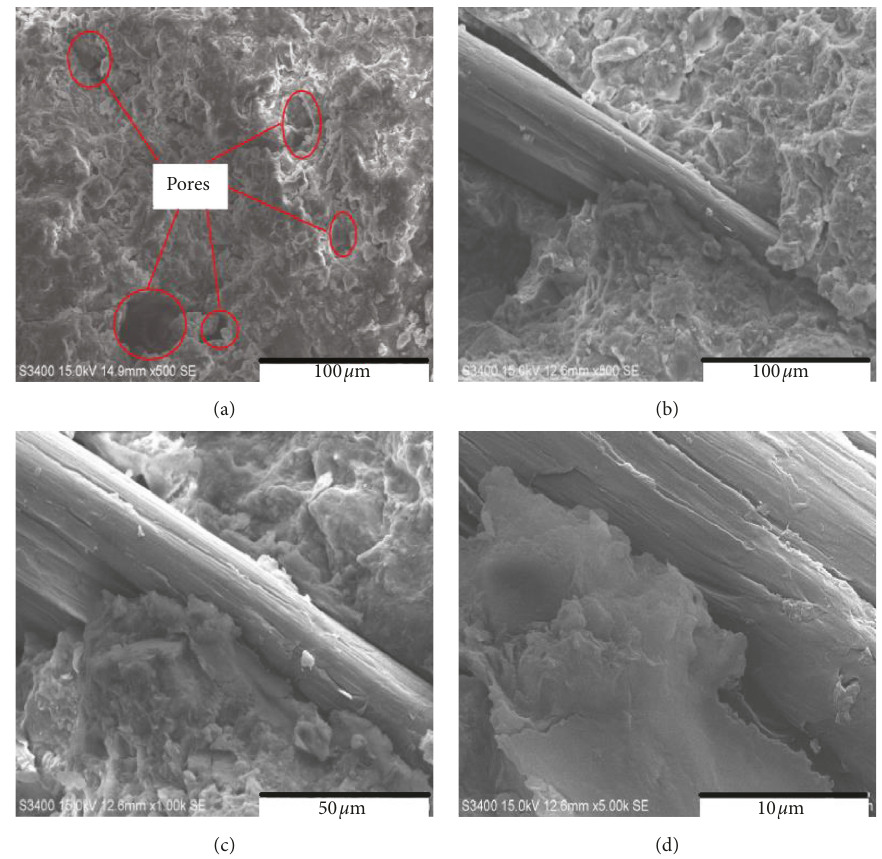
Figure 14: Effect of fiber reinforcement on microstructure of stabilized soil-cement. (a) Without polypropylene fiber ( × 500). (b) With 0.4% polypropylene fiber ( × 500). (c) With 0.4% polypropylene fiber ( × 1000). (d) With 0.4% polypropylene fiber ( × 5000).